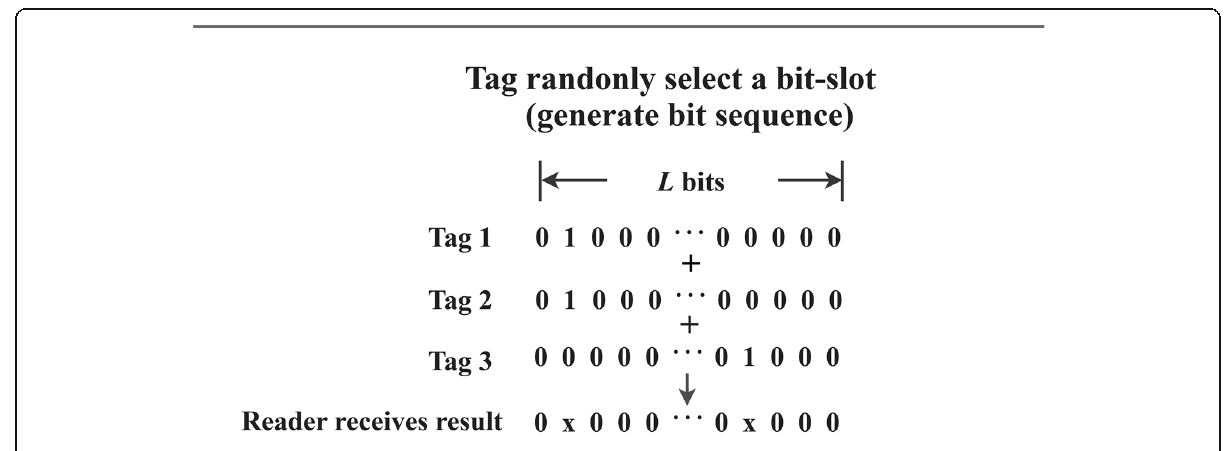
Fig. 4 Generation of bit